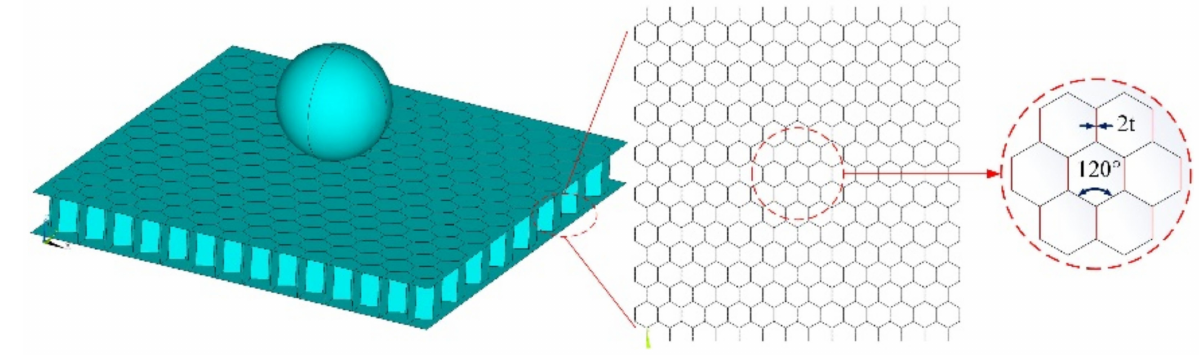
Figure 3. Verification model, this